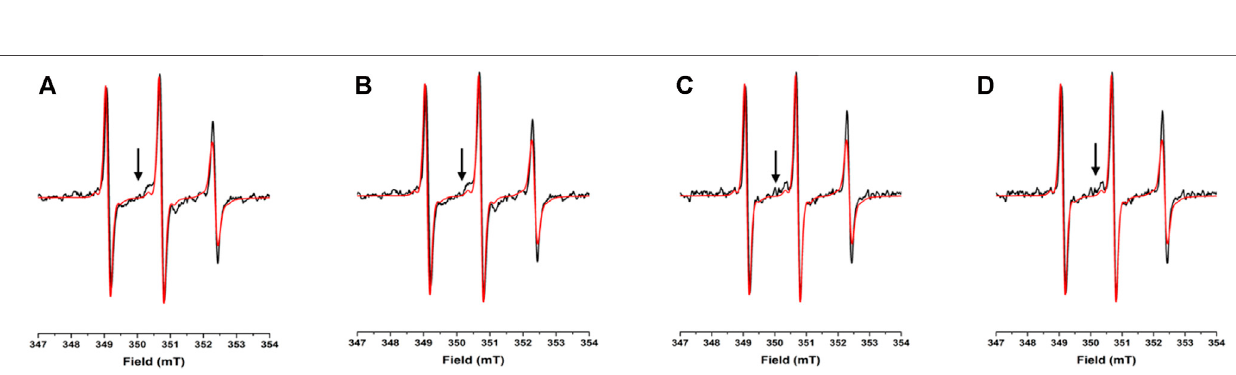
TABLE 1 | Correlation times ( τ c ) and component percentage (%) of the A2C-MTSL EPR spectra recorded under different solution conditions at 25 ° C a . Conditions Sharp component Broad component — τ c (ns) Population (%) Aqueous solution 0.12 Ficoll-70 (50 mg/ml)